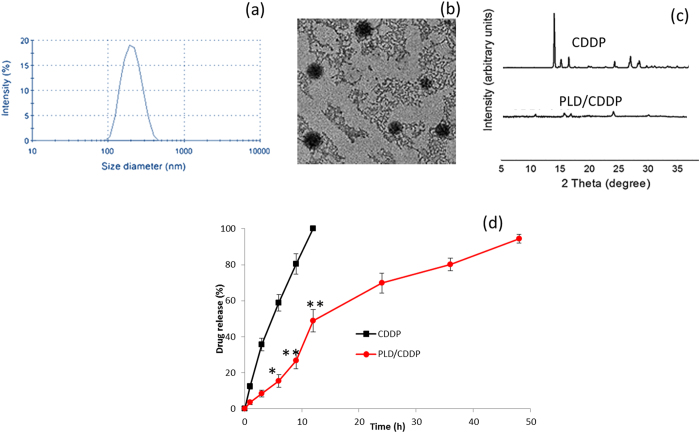
Physicochemical characterization of PLD/CDDP nanoparticles.(a) Size distribution analysis of PLD/CDDP evaluated using zetasizer, (b) TEM images of PLD/CDDP, (c) X-Ray diffraction analysis of free CDDP and PLD/CDDP. (d) In vitro release profile of CDDP from PLD/CDDP nanoparticles. The study was performed in phosphate buffered saline (pH 7.4) at 37 °C. Data are expressed as standard deviation of the mean and n = 3. *p < 0.05 and **p < 0.01 is the statistical difference between tumor volume of CDDP and CDDP/PLD treated group.